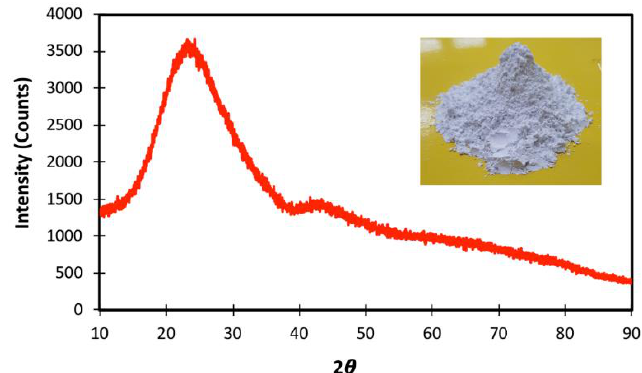
Figure 1. XRD of LGP particles.